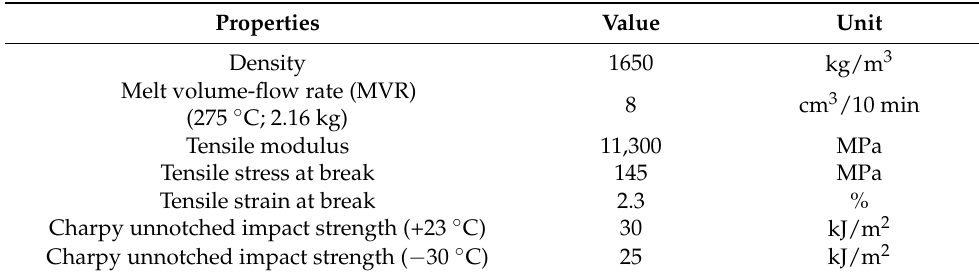
Table 1. Typical properties of ULTRADUR ® B 4406 G6. Properties